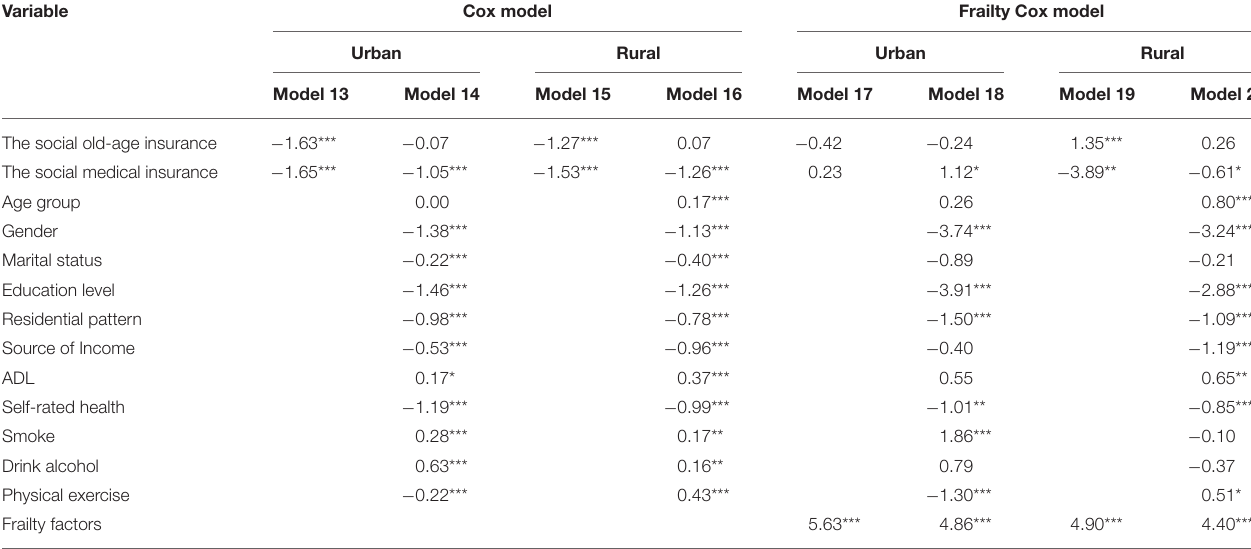
TABLE 4 | The regression results of the Cox model and the frailty Cox model under the samples of urban/rural areas.